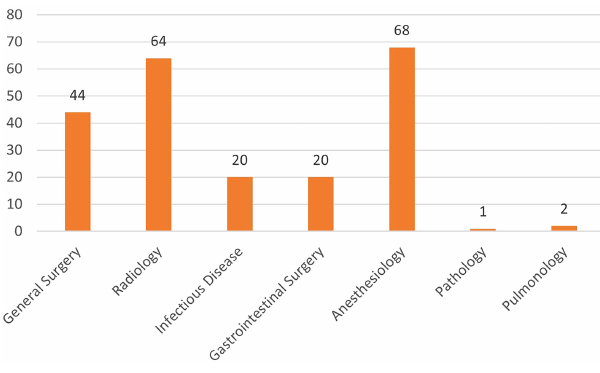
Figure 3. Other departments that disrupt patient